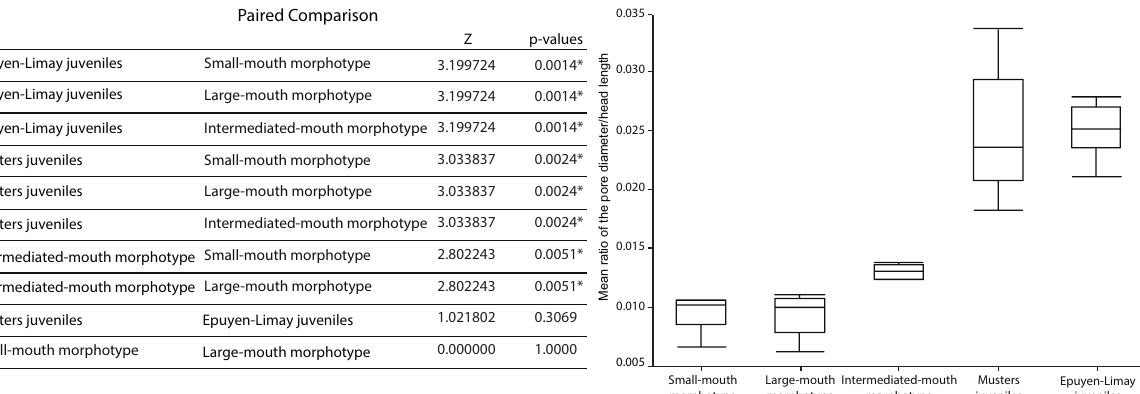
Figure 13. Paired comparison and box plot showing the mean of the relation of pore diameter/head length ratio comparing the first seven pores of the horizontal part of the preopercular-mandibular canal among the small-mouth morphotype, the large-mouth mor- photype, the intermediated-mouth morphotype, and the Musters and Epuyen-Limay groups of juveniles. *Shows significant differences. Significance level: